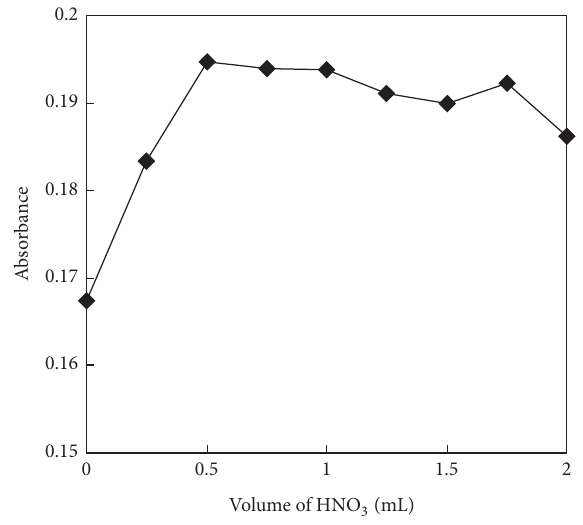
F 8: Effect of the amount of HNO